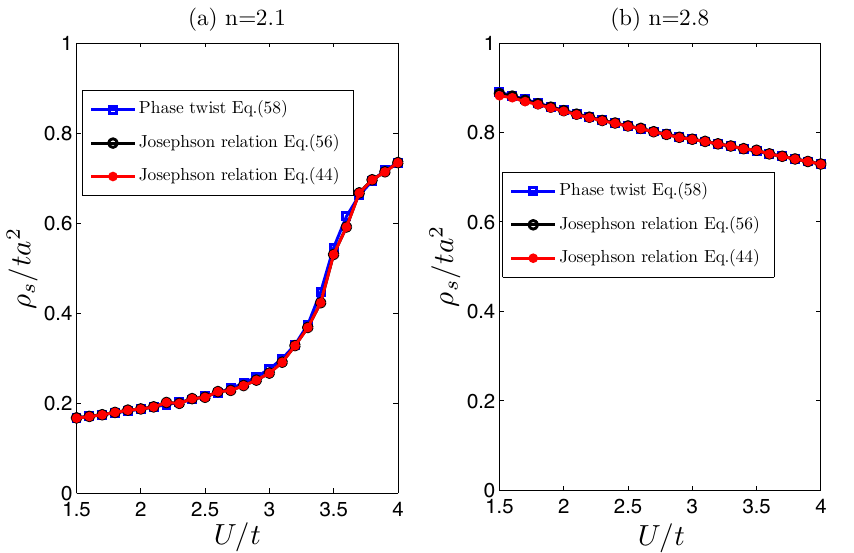
Figure 1. Superfluid densities (particle number per unit cell) are plotted as functions of interaction U . ( a ) Filling factor n = 2.1 , t ′ = 0.15 t , M = 0 and φ = π/ 2 ; ( b ) filling factor n = 2.8 , t ′ = 0.15 t , M = 0 and φ = π/ 2 . The the superfluid density in the three curves are obtained through three different formulas, i.e., Eqs. (58), (56) and